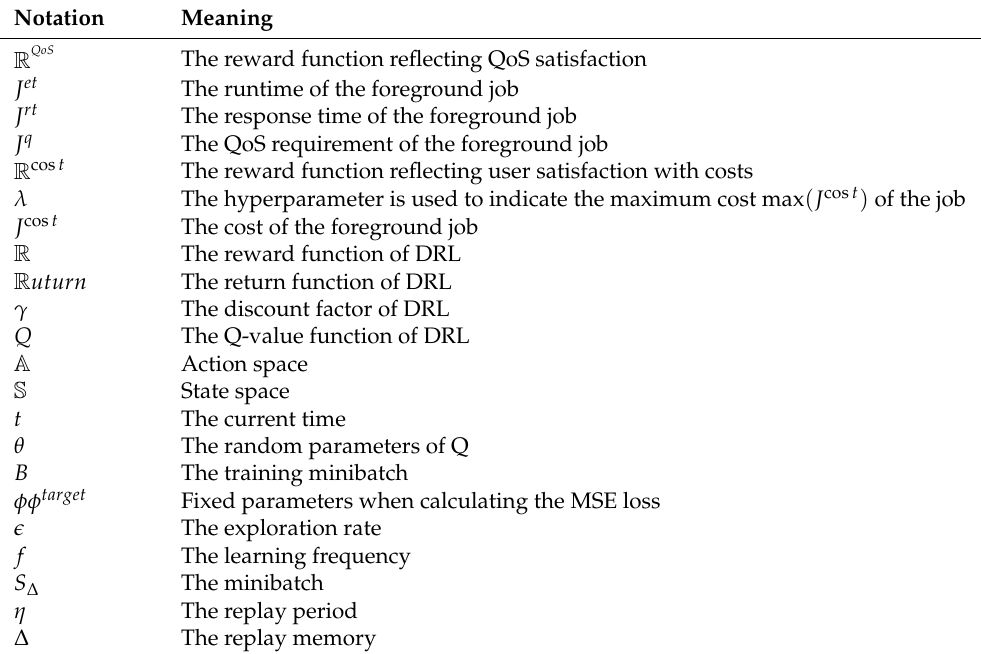
Table 2. Notations used in our DRL-based